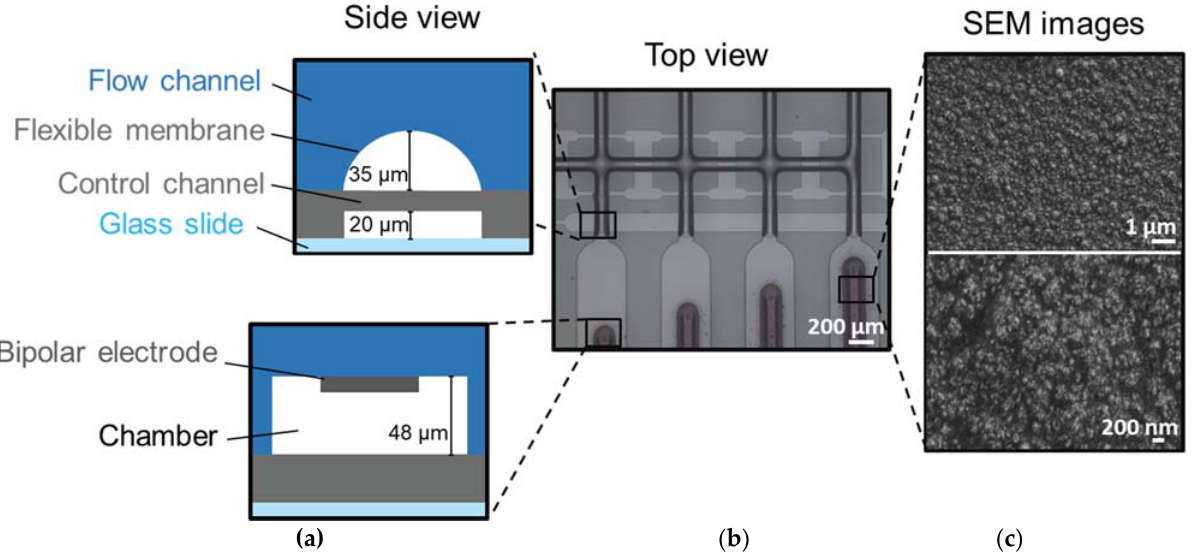
Figure 3. ( a ) Schematic cross ‐ section and ( b ) optical image of the multiplexed PDMS microfluidic device. Pt NPs are printed in the chip chambers (flow layer). ( c ) SEM images of the morphology of Pt NPs patterns deposited on the PDMS substrate. Voltage/current settings used for the deposition, V = 1.3 kV and I = 10 mA, respectively, speed of printing of 10 μ m/s, and nozzle ‐ substrate distance of 500 μ m. Film thickness of ~0.4 μ m.